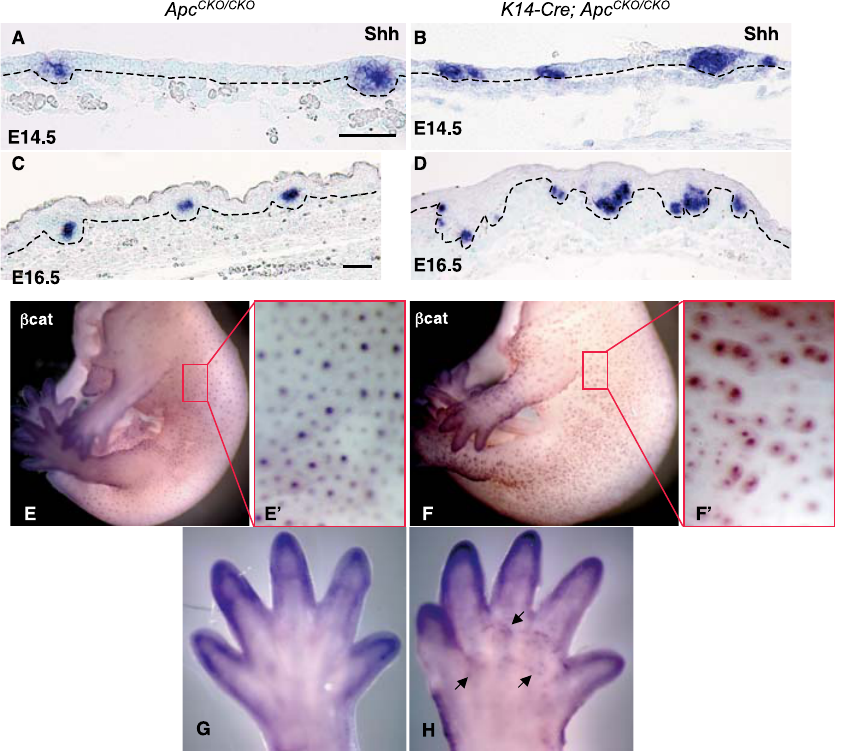
Figure 5. Expression of Shh and b -catenin Transcripts in Normal (Apc CKO/CKO ) and Mutant (K14-cre; Apc CKO/CKO ) Embryonic Skin (A–D) Section ISH with Shh probe in E14.5 normal (A), E14.5 mutant (B), E16.5 normal (C), and E16.5 mutant (D) skin. Broken lines indicate the interface between epithelium and mesenchyme. Scale bars: 50 l m. Whole mount in situ detection of b -catenin in E15.5 normal (E, G), mutant (F, H) embryos. Aberrant initiation of multiple hair placodes is evident at E14.5. Loss of K14 -driven Apc loss caused aberrant pattern formation (F 9 ) and formed ectopic hair placodes in normally hairless foot pads (H, arrows) which are absent in normal